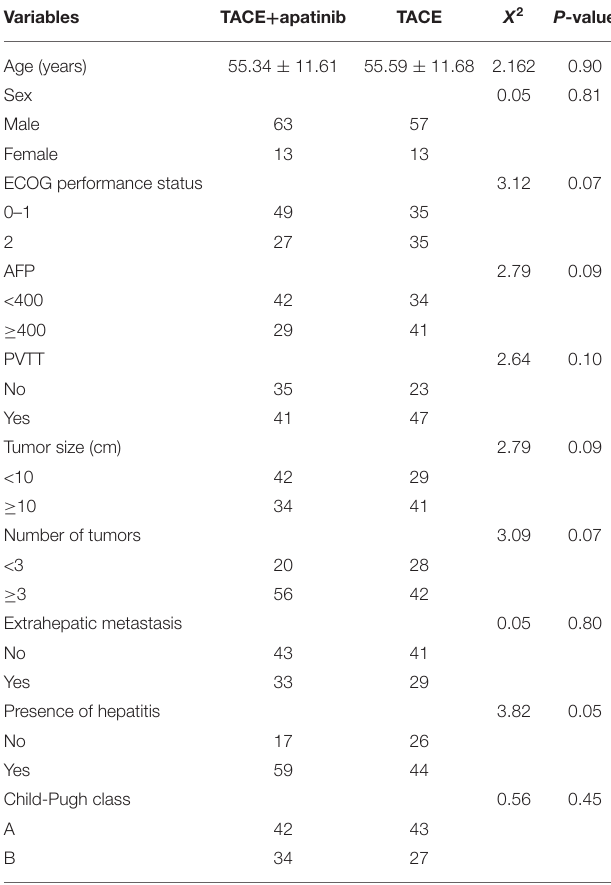
TABLE 1 | Comparison of baseline characteristics between the two